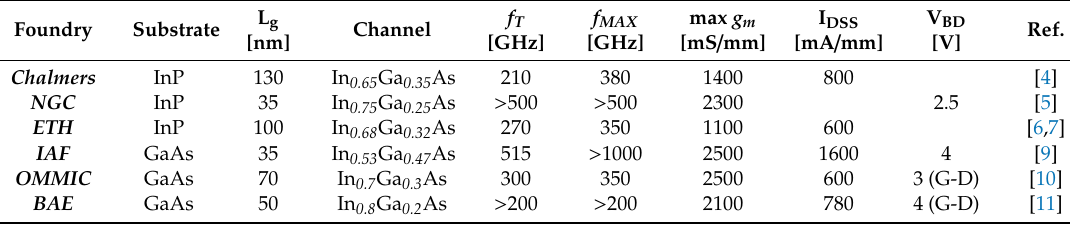
Table 1. Presented HEMT technologies performance